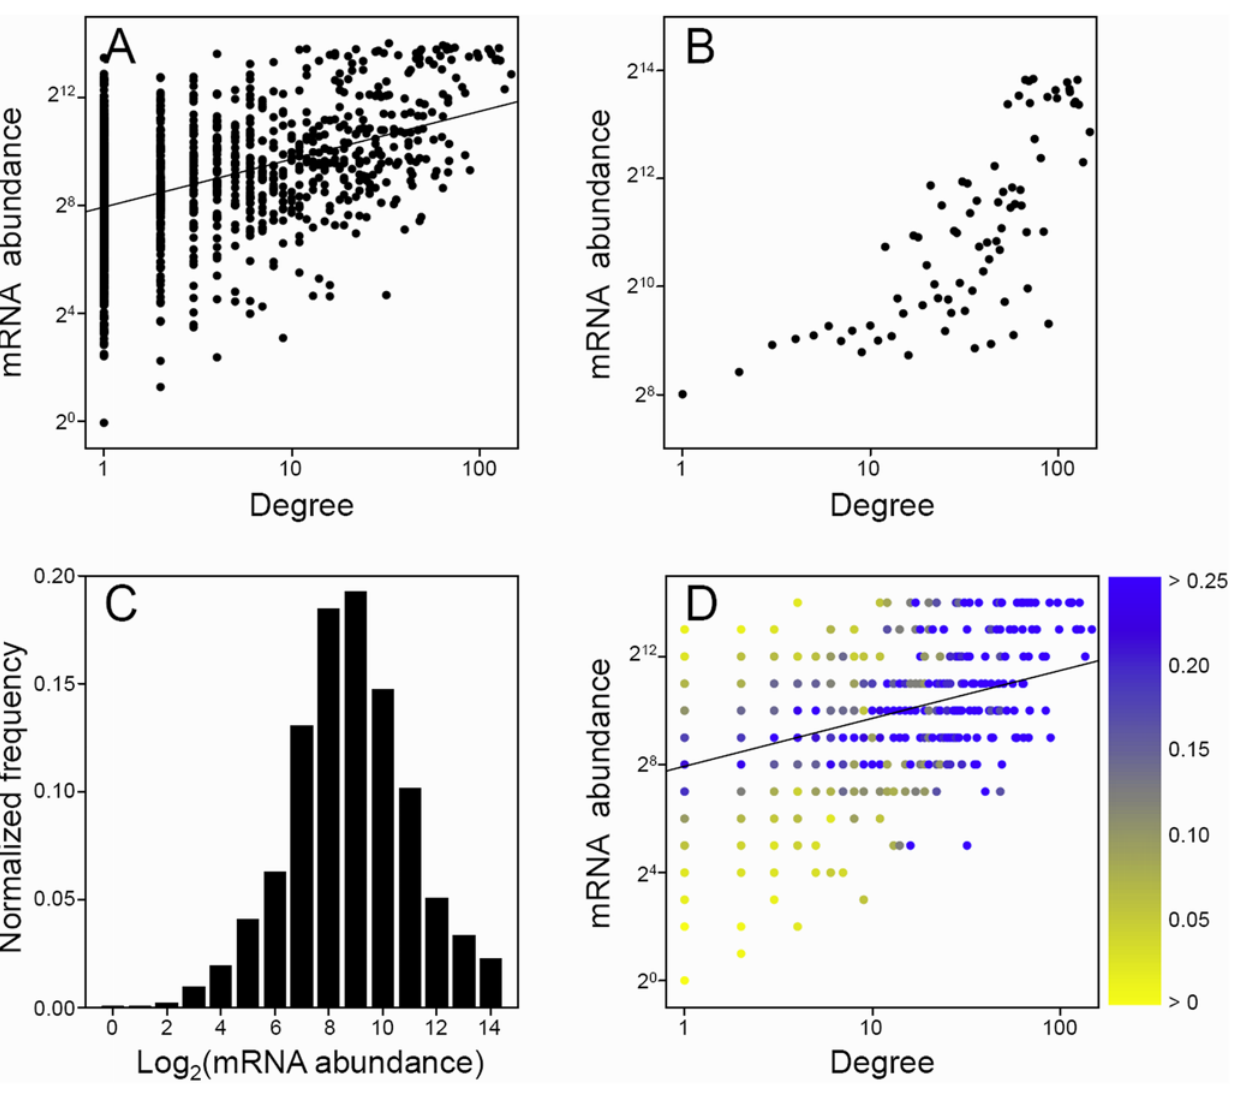
Figure 2. Relationship between protein degree and abundance in the raw E.coli TAP Butland PPI network [ 10 ] using the gene expression measurements of Covert et al. [48]. (A)–(D), see Figure 1 legend.